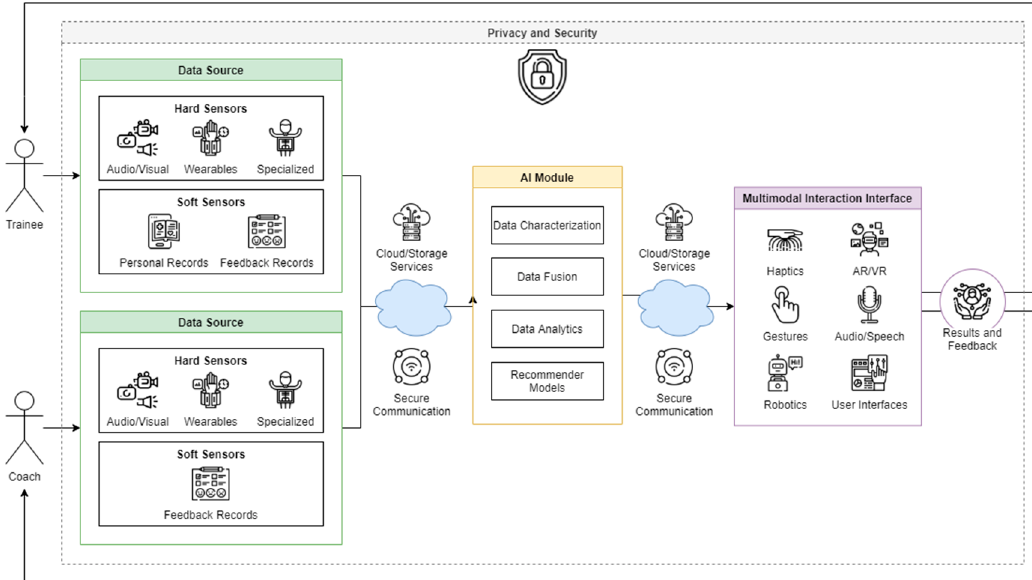
Figure 3. DT Coaching Ecosystem adapted from [25,82]. Icons from flaticon.